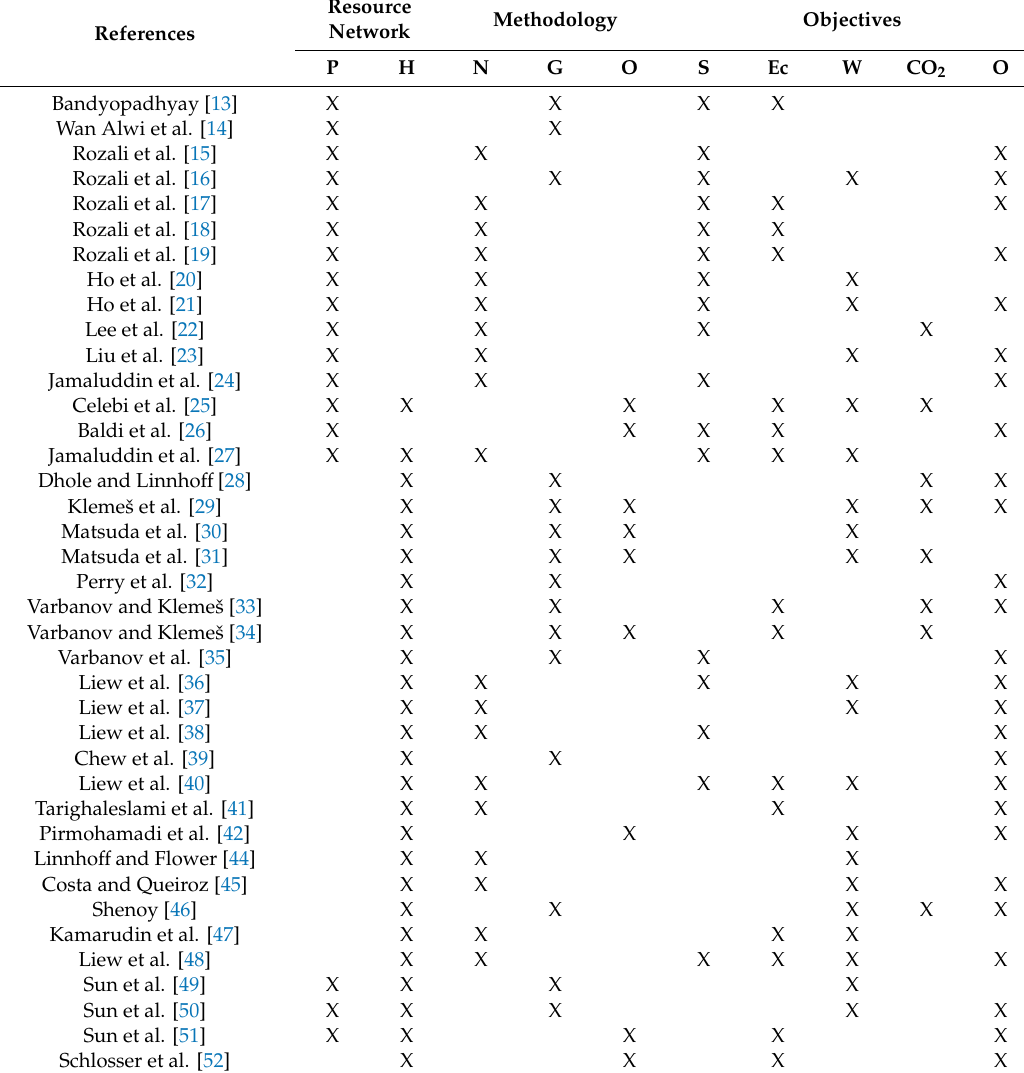
Table 1. Overall summary of the previous heat and power Pinch Analysis (PA) methodology that had been developed (adapted from Klemeš et al.